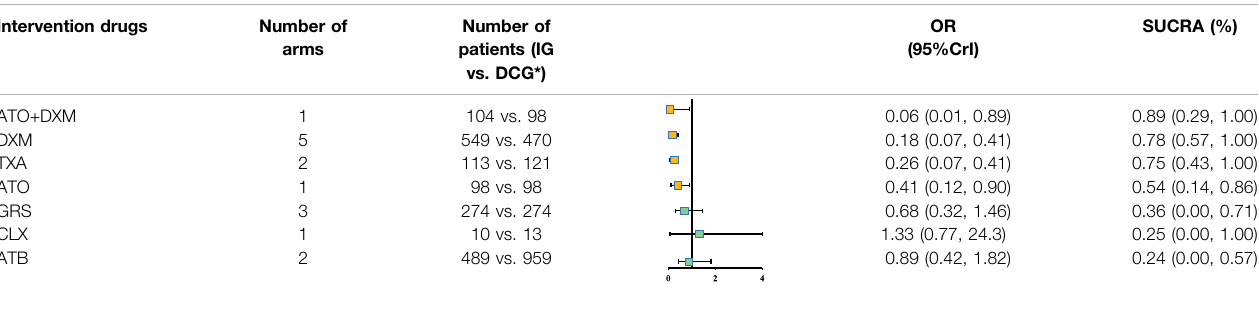
TABLE 3 | Ef fi cacy of different intervention drugs compared to designated control